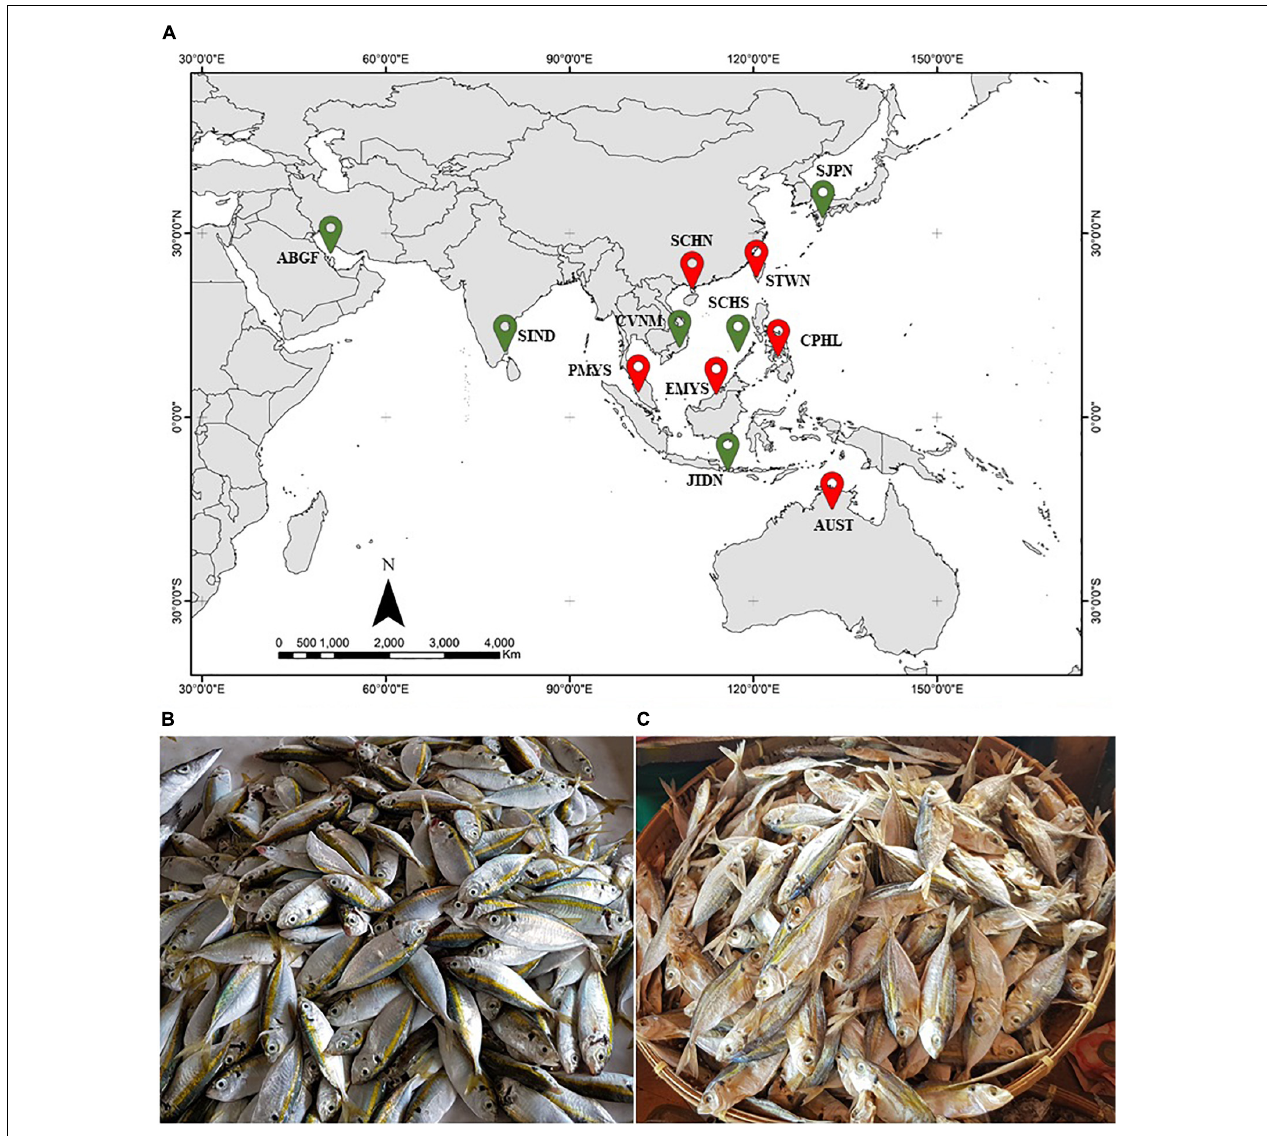
FIGURE 1 | (A) Major collection sites from this study indicated by ( n > 10 individuals) and ( n < 10 individuals). The map is courtesy of The World Bank Org (2021). (B) Fresh and (C) dried S. leptolepis sold at a local fish market in Central Philippines (CPHL).